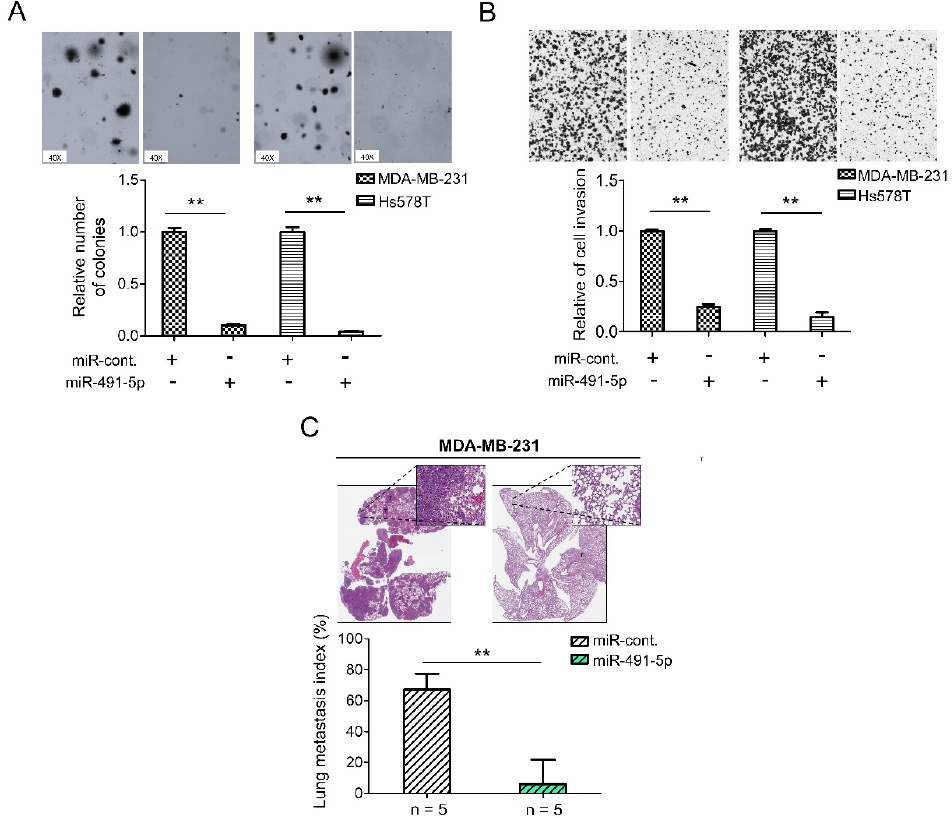
Figure 2. miR-491-5p suppresses 3D colony formation, cell invasion, and pulmonary metastasis in TNBC. ( A ) Overexpression of miR-491-5p reduced the colony-forming abilities of TNBC cells in a 3D soft agar culture (40 × , bright field) (top). Representative images are shown. Quantitative results from the 3D soft agar assay (bottom). ( B ) Analysis of the effect of miR-491-5p on invasion ability of TNBC cells using Boyden chamber assay. The representative photographs of the invaded cells from different treatments are shown as pictures and the quantitative data are shown by histograms. ( C ) Lung metastasis of five CB17-SCID mice in each group was significantly inhibited after tail vein injection of MDA-MB-231 cells transfected with miR-491-5p shown by histologic staining and lung metastasis index. All histograms represent means ± s.e. from three independent experiments (** p < 0.01).